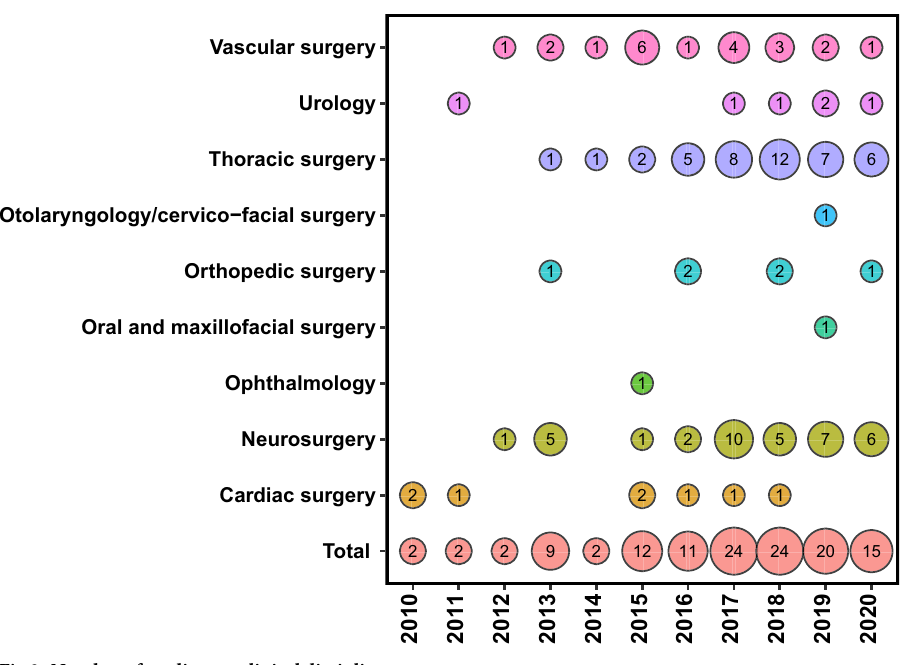
Fig 2. Number of studies per clinical discipline per